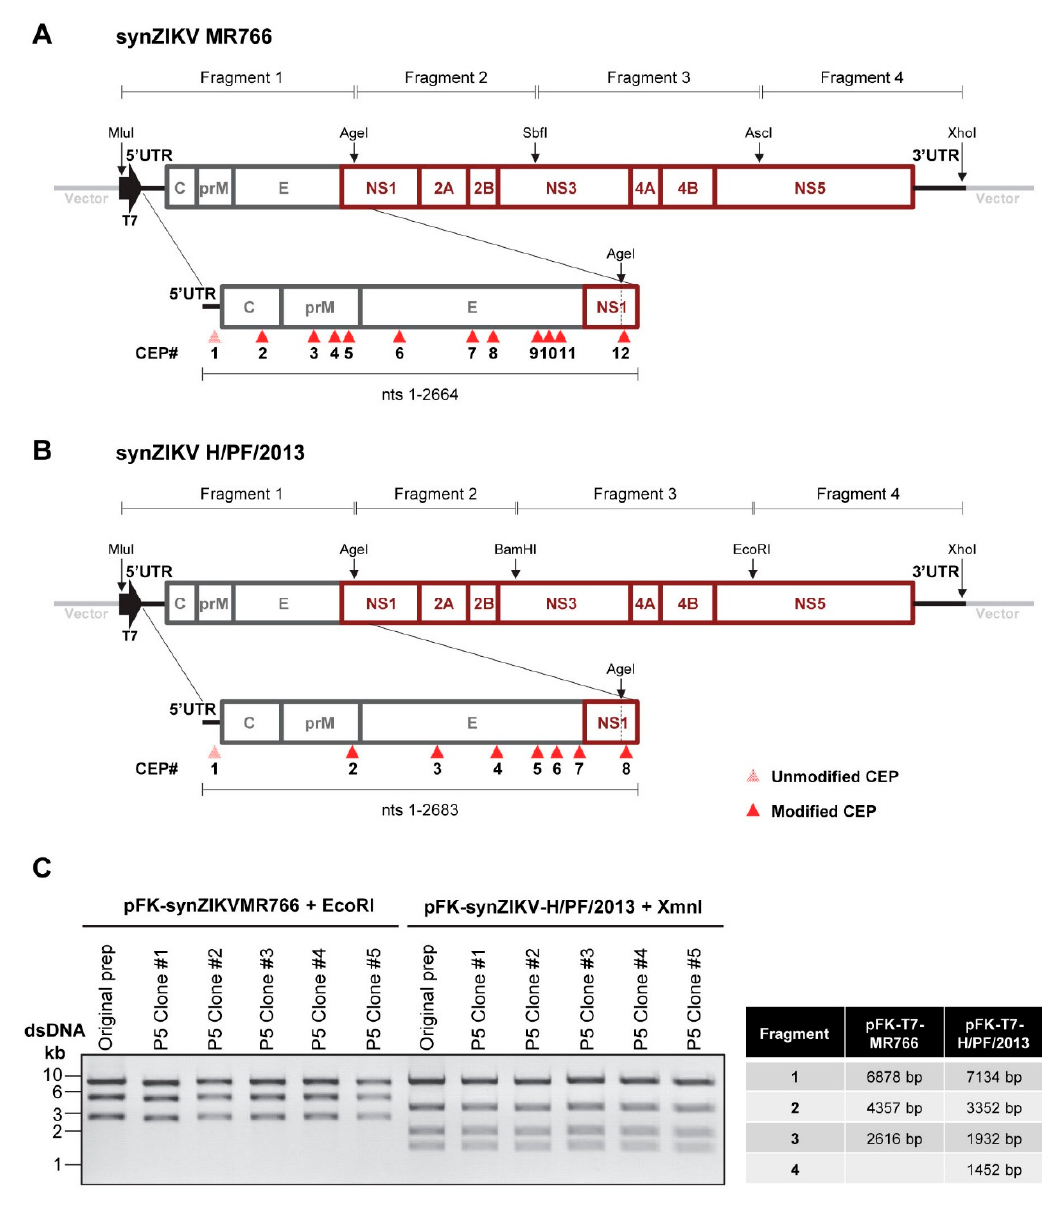
Figure 1. Construction and stability of synthetic full length Zika virus (synZIKV) cDNA clones. ( A ) Schematic representation of the synZIKV MR766 construct and the four fragments used to assemble the genome. The 5 ′ and 3 ′ UTRs are indicated with bold black lines, the promoter for the T7 RNA polymerase with a black arrow. Restriction sites used for the assembly of the fragments are indicated. An enlargement of fragment #1 is shown below with putative CEPs (score > 0.85) indicated by red arrow heads. CEP 1 was not mutated (indicated with the pink arrow head). ( B ) Same as in panel ( A ) but for synZIKV-H/PF/2013. ( C ) Restriction patterns of pFK-synZIKV constructs obtained after digest with EcoRI (MR766) or XmnI (H/PF/2013) and agarose gel electrophoresis. Plasmids were analysed directly after assembly (original prep) and after five passages (P5) in E. coli (five DNA clones of P5 are shown).